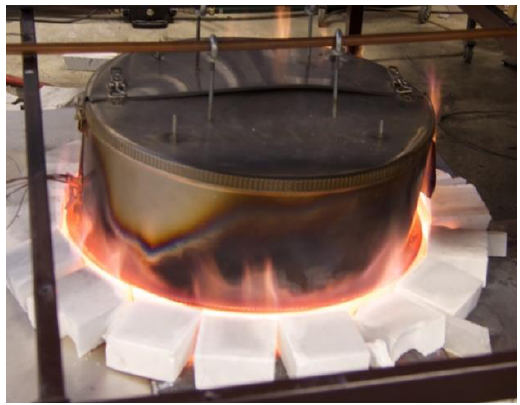
Figure 3. Fire testing with a propane mass flow rate of 0.6 g/s.